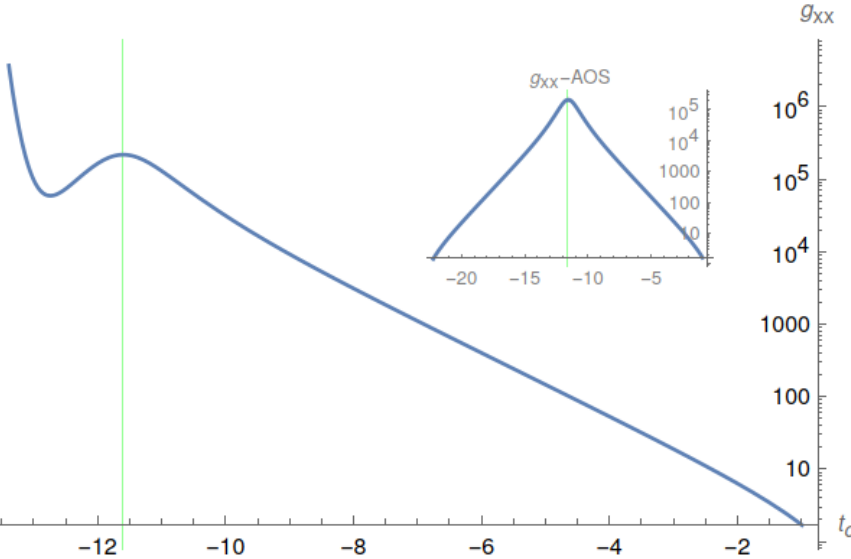
Figure 11. The metric component g xx given in Equation (98). The inserting is the plot of the same quantity for the AOS solution. When plotting this curve, we have chosen the relevant parameters exactly as those given in Figure 7.